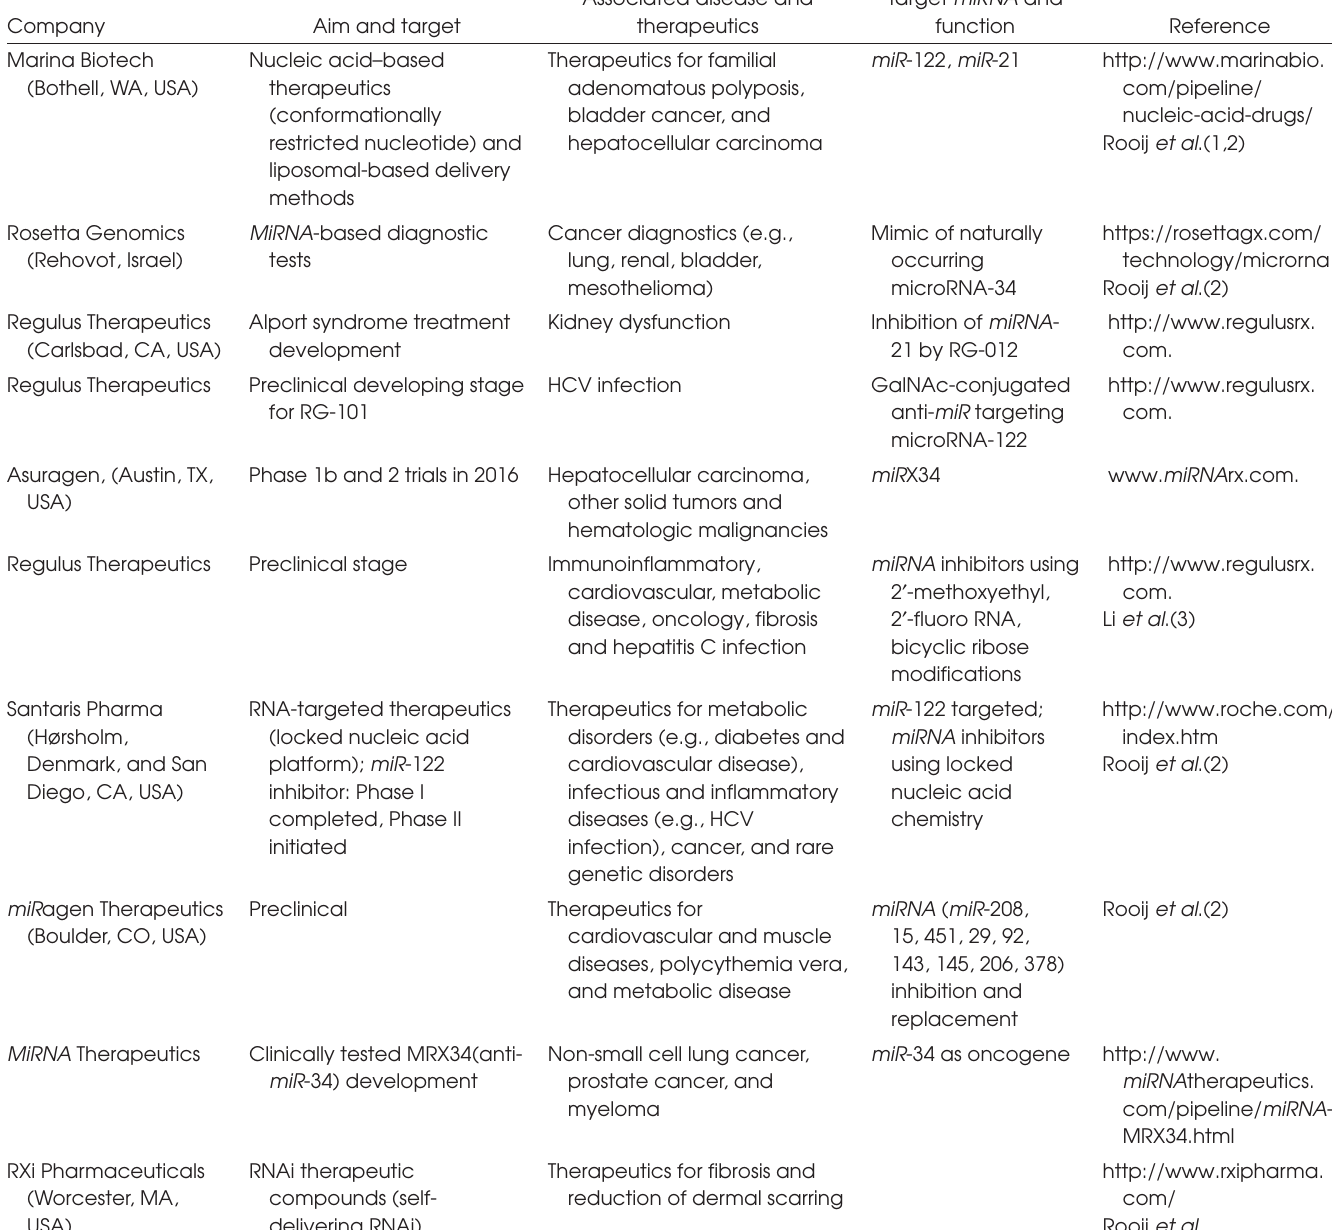
Table 2. Synthesis and development of miRNA -mediated therapeutics in commercial industries.